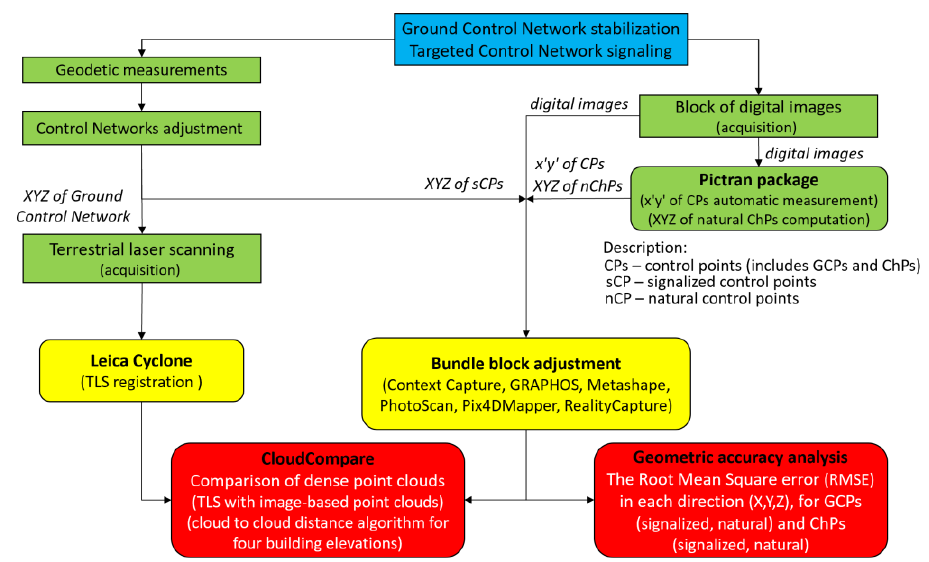
Figure 11. The workflow for image-based and TLS point clouds accuracy analysis. Table 4. The RMSE values on GCPs obtained in tested software after BBA.